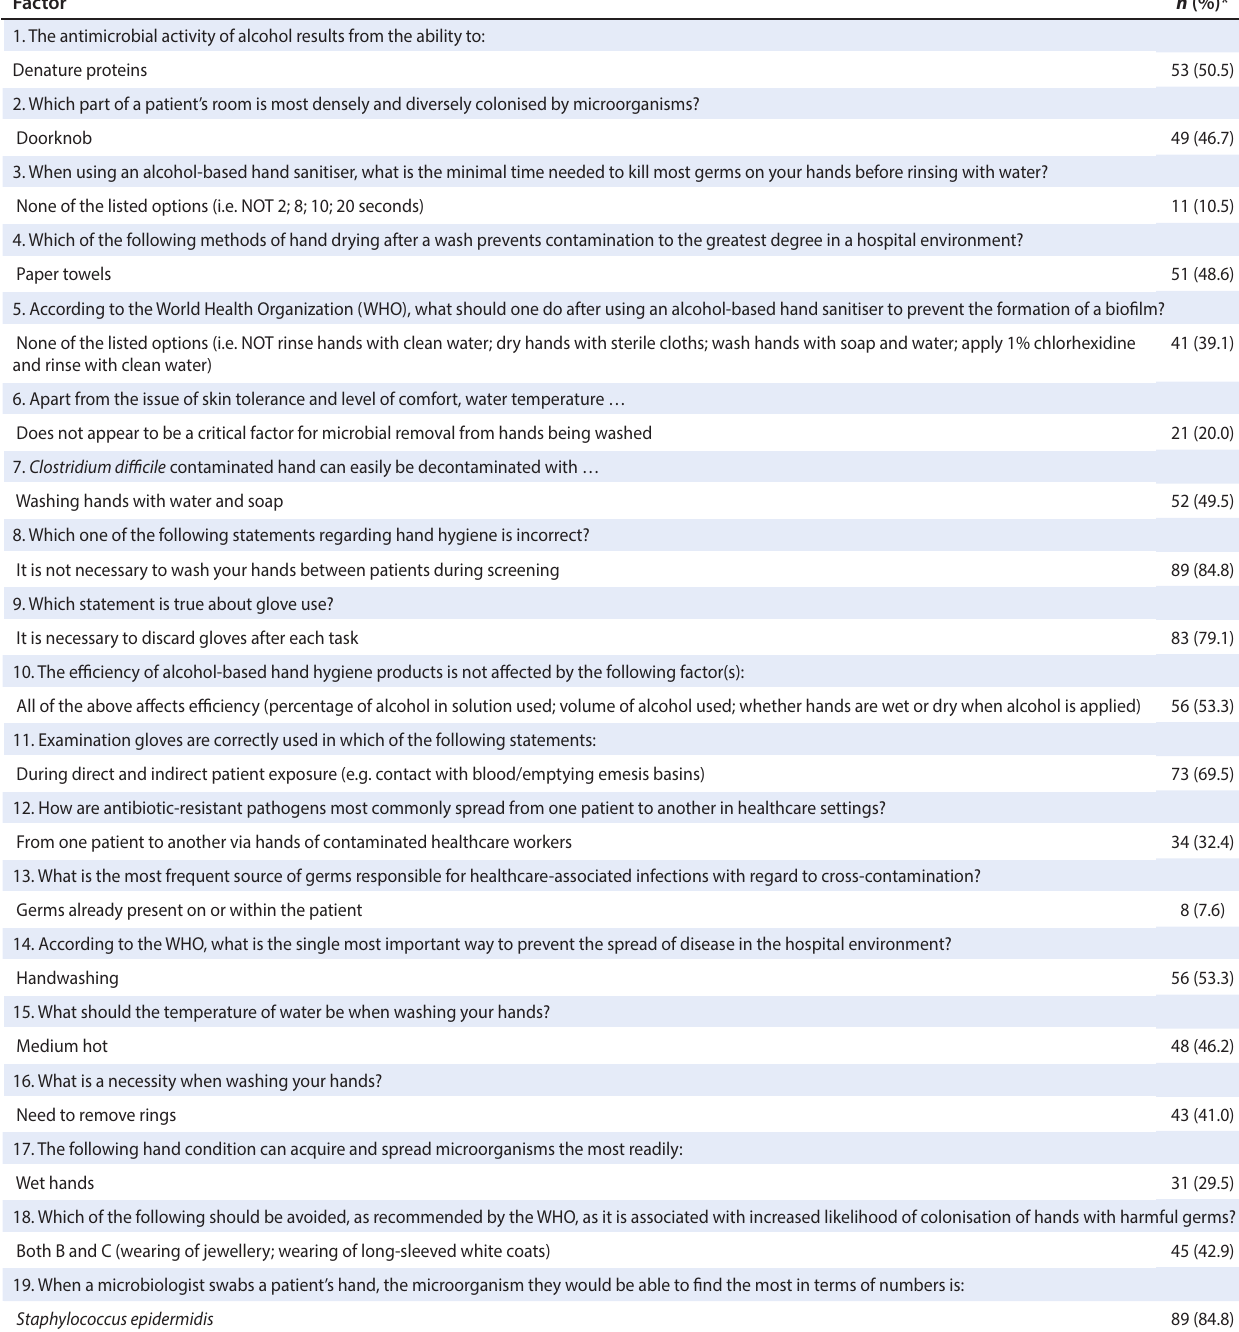
*The results indicate n (%) students who chose the correct